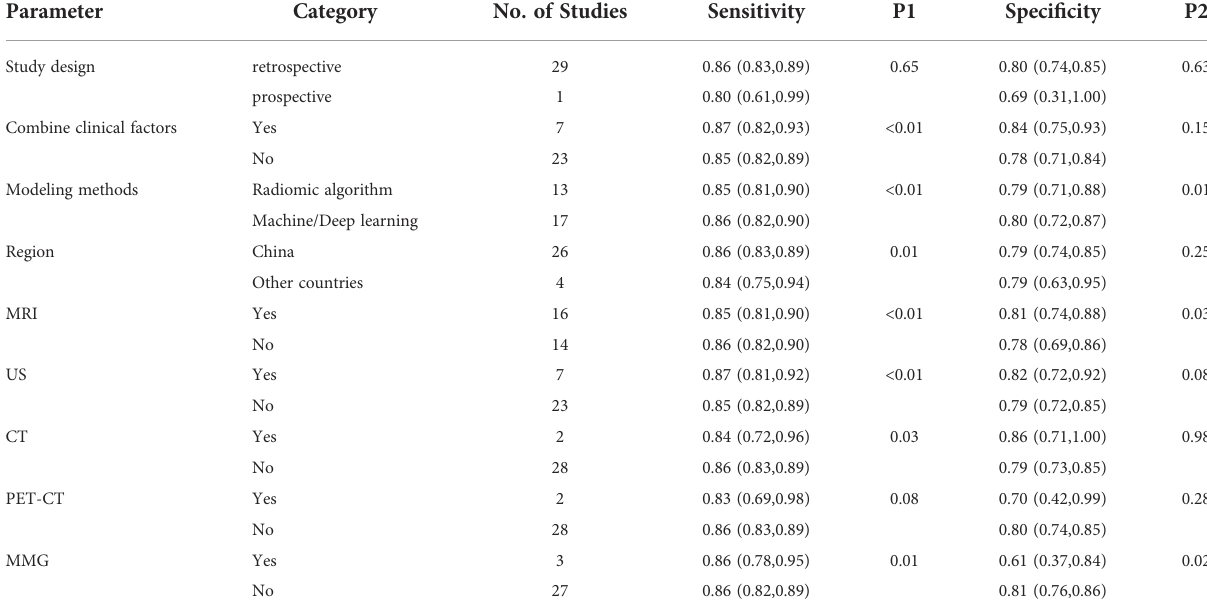
TABLE 2 Univariable meta-regression and subgroup